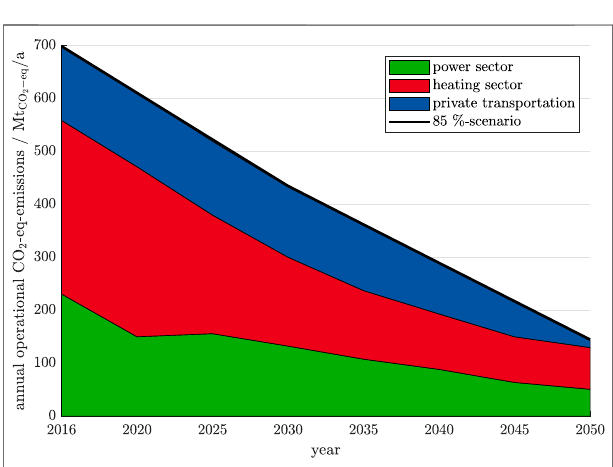
FIGURE 1 | Operational GHG emissions for the transition path consideringthe85%reductiontargetcomparedto1990(966 MtCO 2- eq ).The 85%-ScenarioisbasedonthetargetsoftheGermanFederalGovernmentofa 55% reduction by2030, 70% by2040, and 80 – 95%reductionby 2050. We assume a linear reduction of emission limits. The emissions are assigned to the power, heating, and private transportation